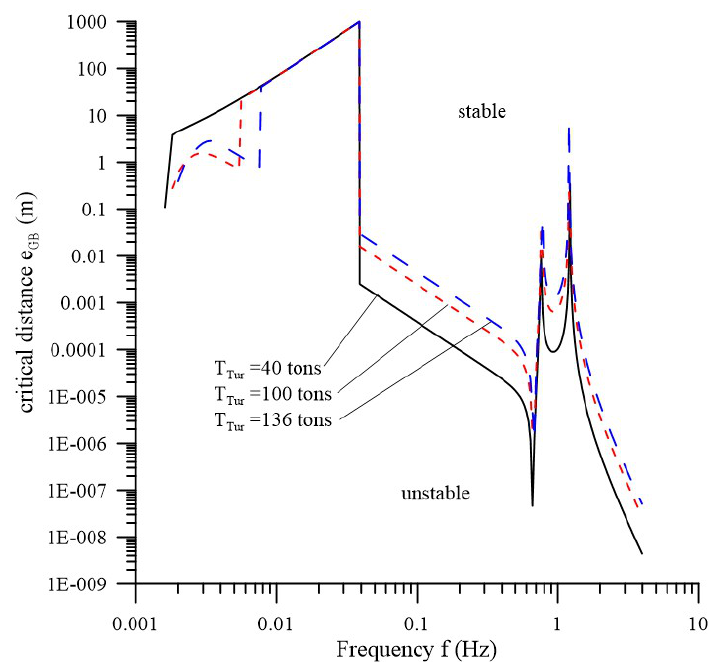
T on the critical distance between the Figure 8. Effect of the wave frequency f and drag force T Tur on the critical distance between the centers of Figure 8. Effect of the wave frequency f and drag force Tur gravity and buoyance for resonance. ( C D = 1.0, V = 1 m/s, e D = 1 m, (cid:96) = 1 m, I = 8.33 × 10 8 ( kg − m 2 ) ; centers of gravity and buoyance for resonance. ( other parameters are the same as those in Figure 4).